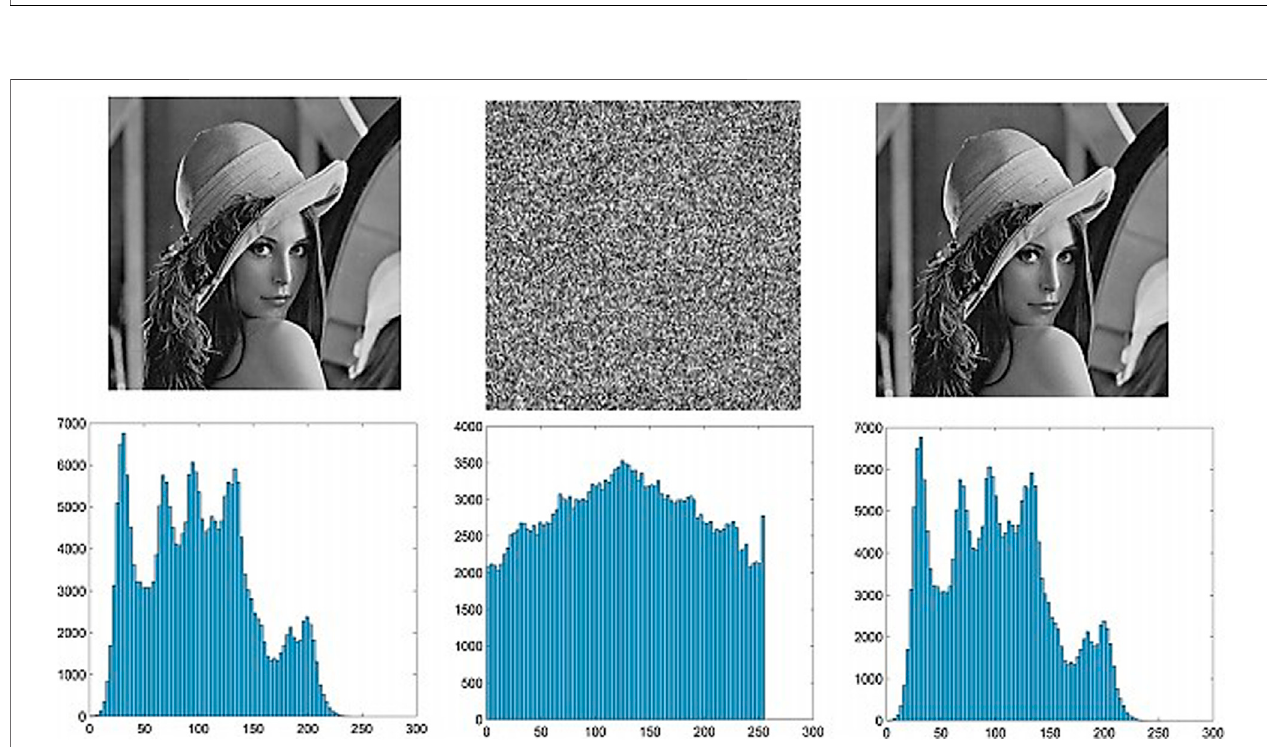
FIGURE 3 | Lungs with COVID-19 pneumonia on the left and lungs without COVID-19 pneumonia on the right.